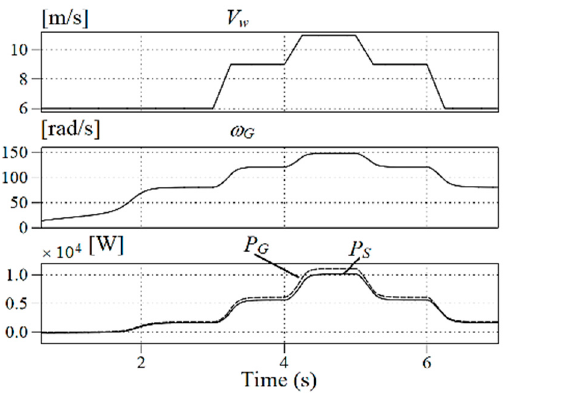
Figure 10. Assumed changes in wind speed V w ( a ) 12, 8, − 8, − 12 [m/s 2 ]; ( b ) 24, 24, − 24 − 24 [m/s 2 ] and corresponding changes in angular velocity ω G , generator power P G , and power grid P S.